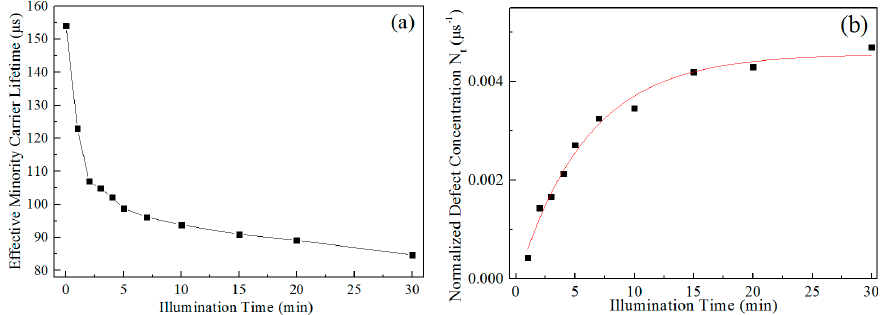
Figure 2. ( a ) Effective minority carrier lifetime decay of a boron-doped mc-Si lifetime sample with symmetrical passivation structure and sintering peak temperature of 805 °C due to illumination at ∆ n = 1 × 10 15 cm − 3 ; ( b ) Normalized defect concentrations N t calculated according to the effective minority carrier lifetime decay. The red curve is the fitting result.